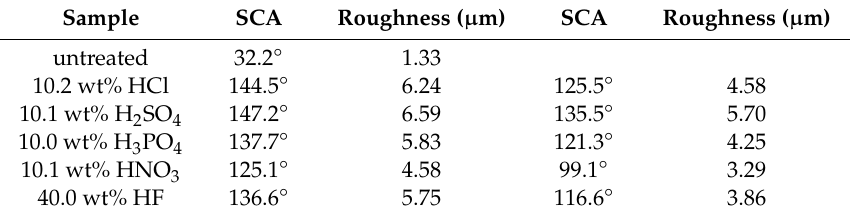
Table 1. The static water contact angle and surface roughness of Ni metal.